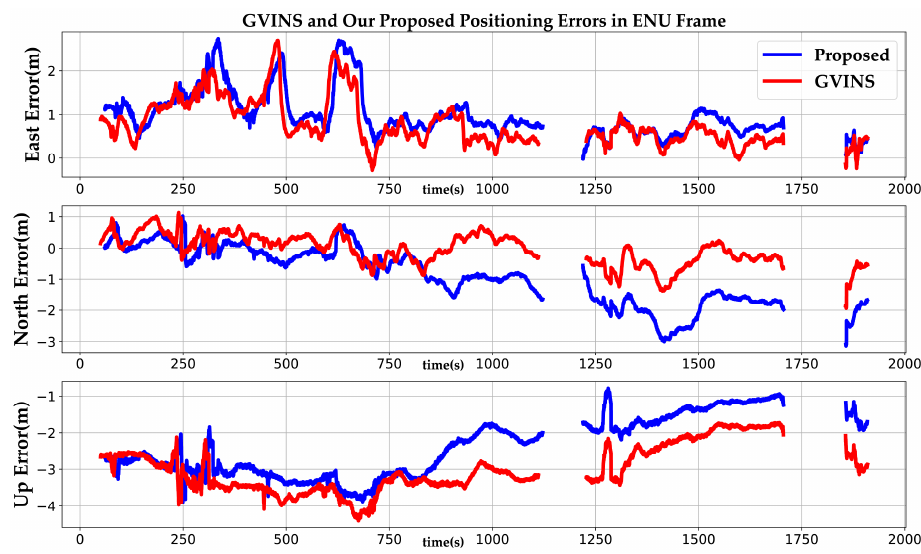
Figure 8. The positioning errors of GVINS and our proposed system in the complex environment. Table 2. RMSE[m] and SEP[m] statistic of GVINS and our proposed method in the complex environment. ENU Frame RMSE SEP East North Up GVINS 1.091 0.782 3.016 2.540 Proposed 1.230 1.404